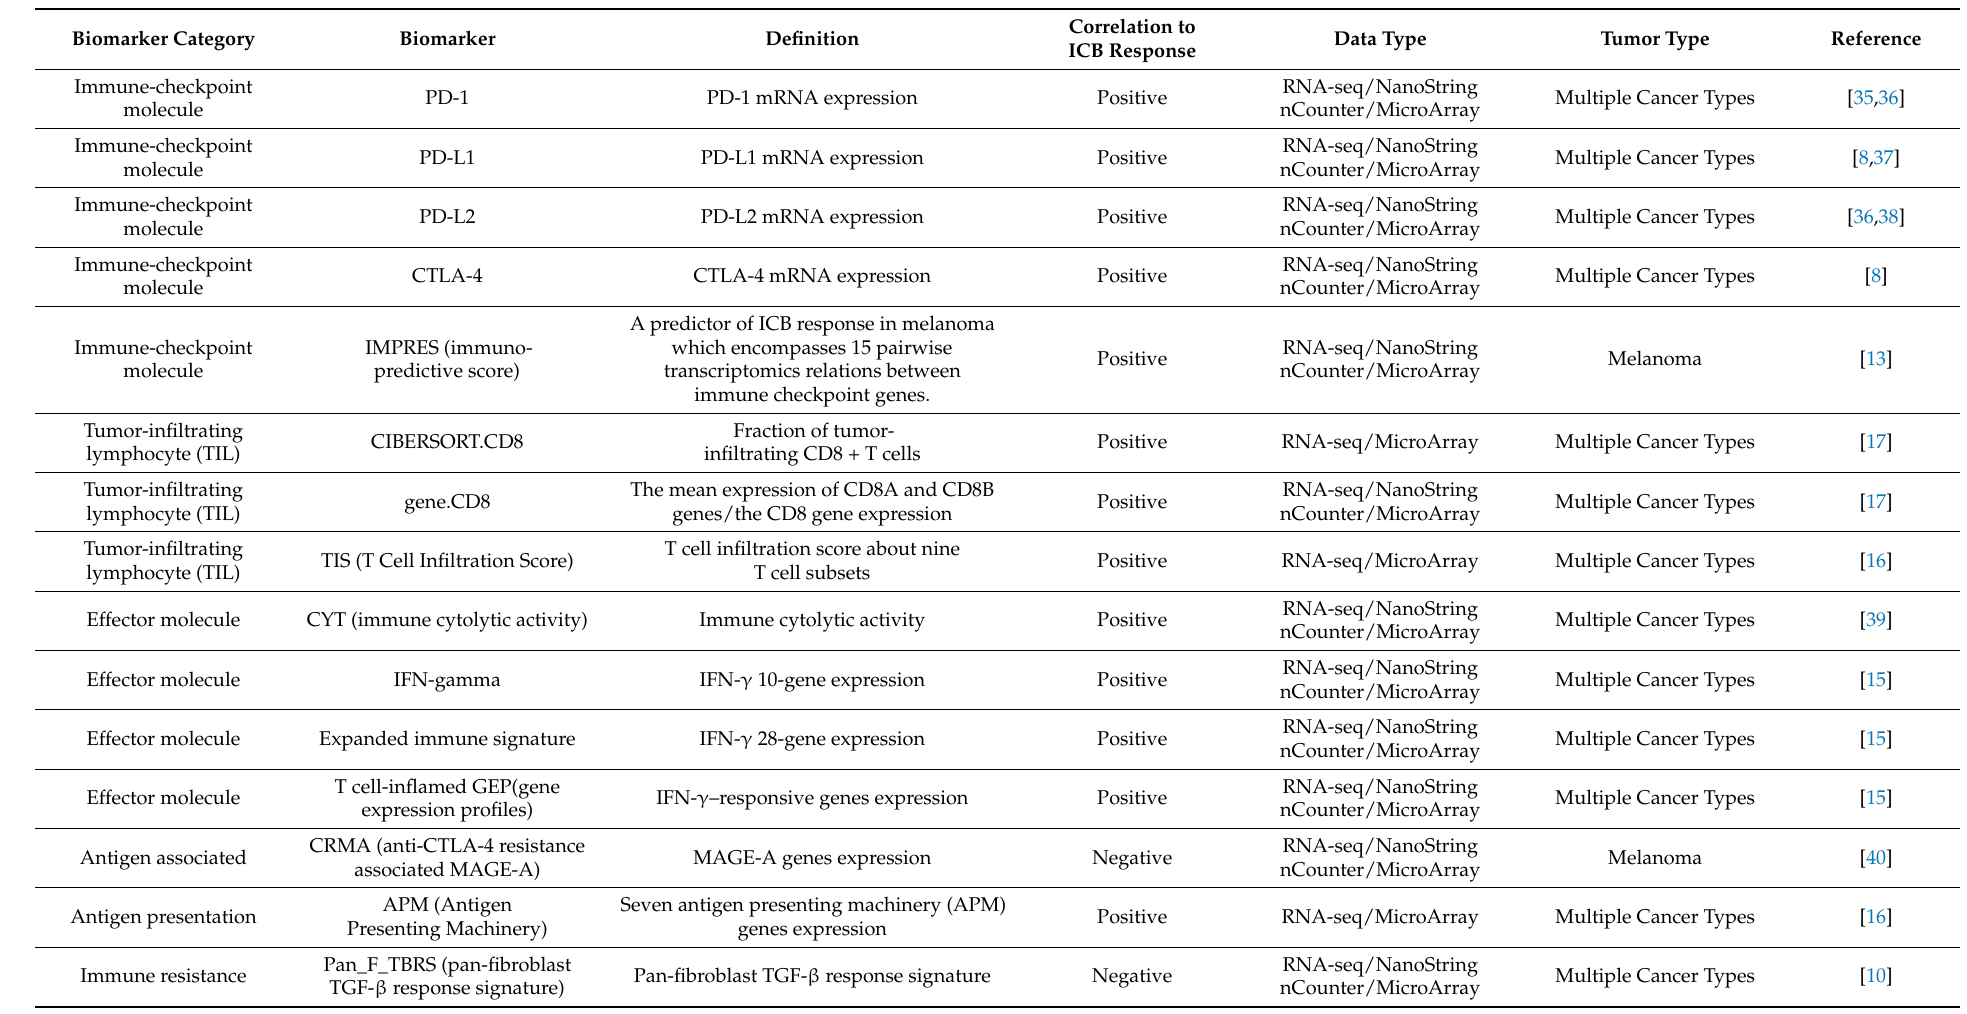
Table 2. Summary of 22 transcriptomic predictive biomarkers included in this study for ICB response